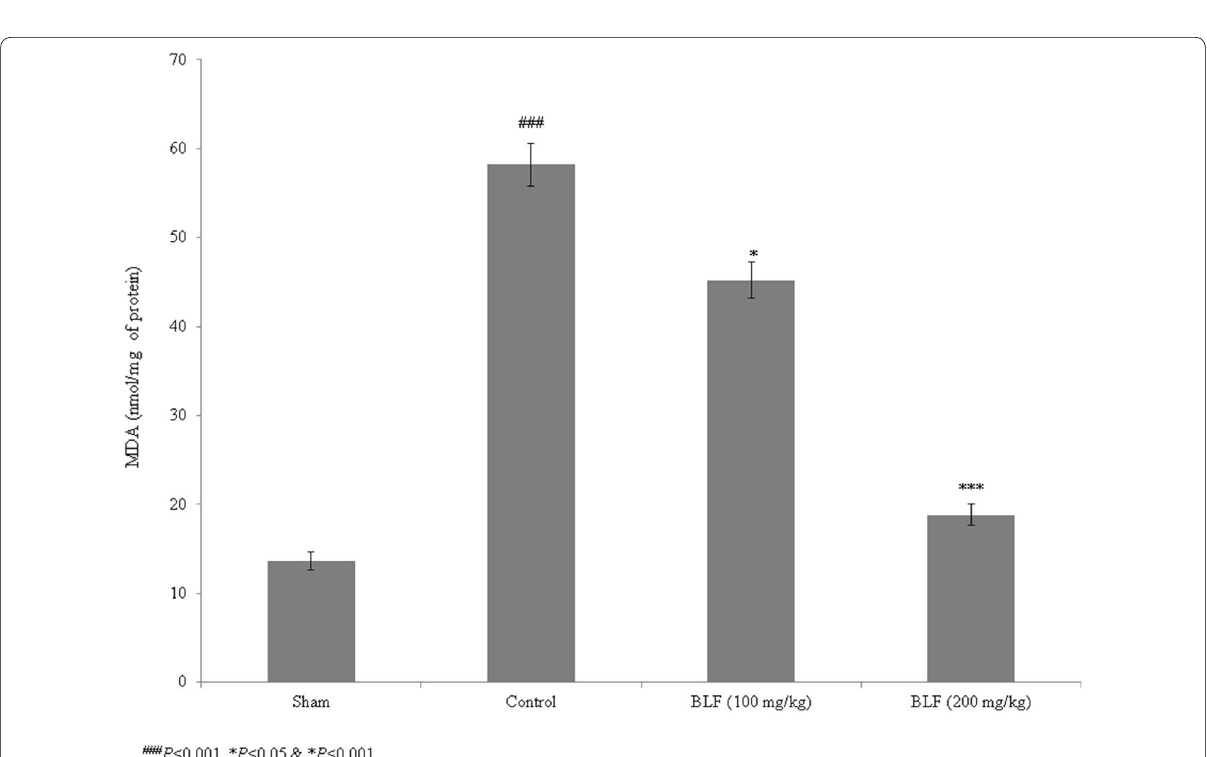
Fig. 2 BLF reduces lipid peroxidation in lung tissue homogenate of ALI-induced male albino rats. Rats were given BLF for 30 consecutive days through oral gavage. ### P < 0.001 compared to the sham group; * P < 0.05 and *** P < 0.001 compared to control